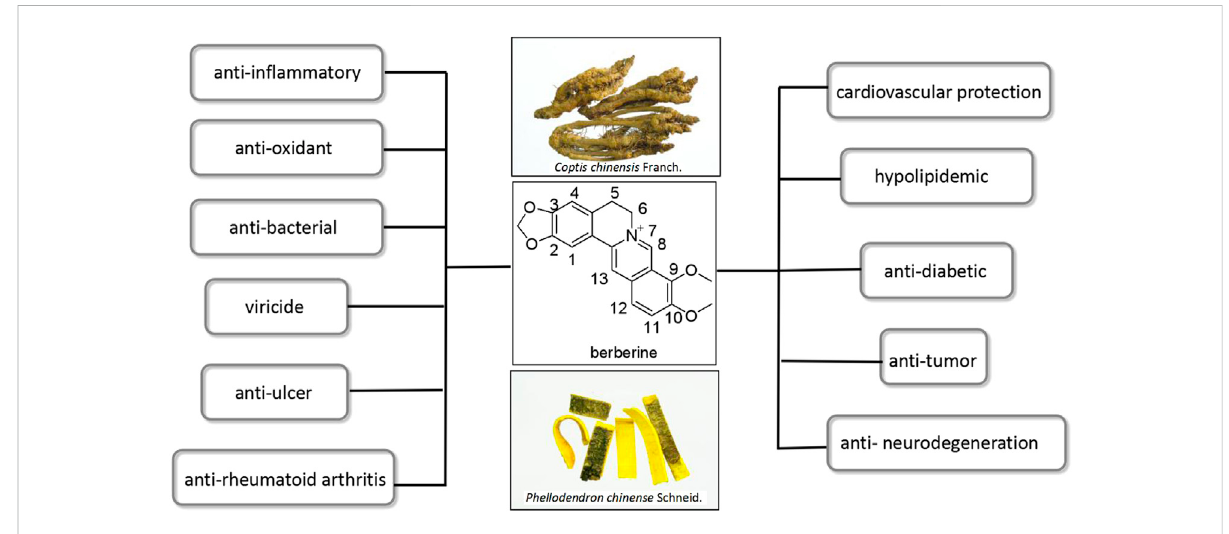
FIGURE 1 Pharmacological activities of BBR.